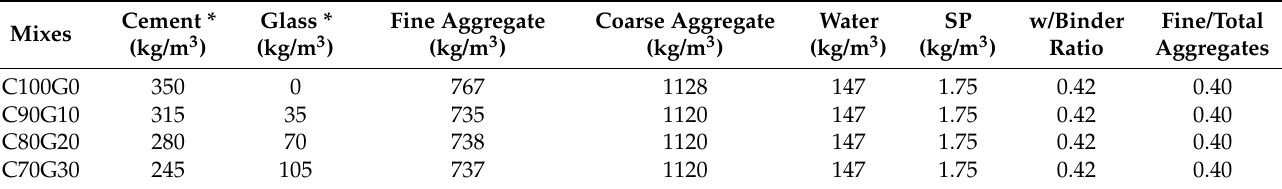
Table 4. Mixture proportion in 1 m 3 of cement–glass binary blended